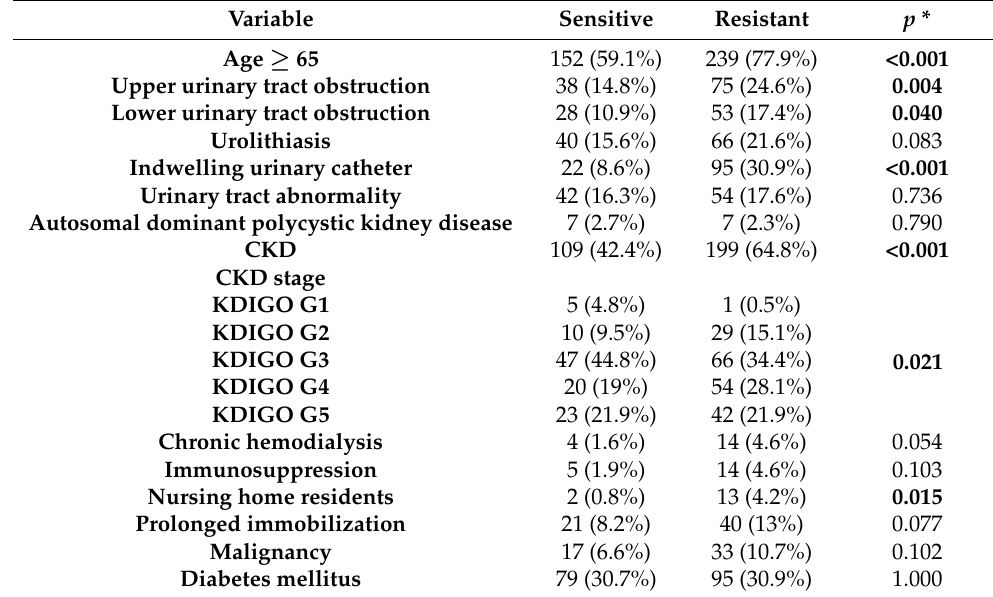
Table 3. Univariate analysis of risk factors for general antibiotic